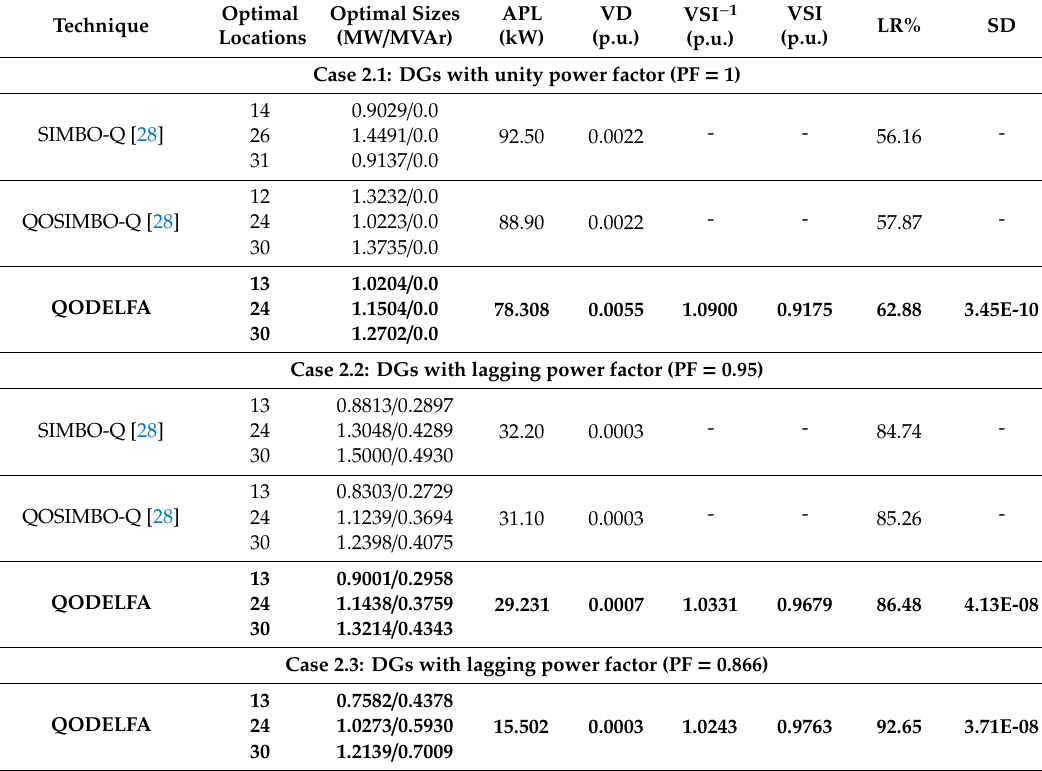
Table 4. Results for the IEEE 33-bus RDS with simultaneous minimization of OF 1 and OF 2 .